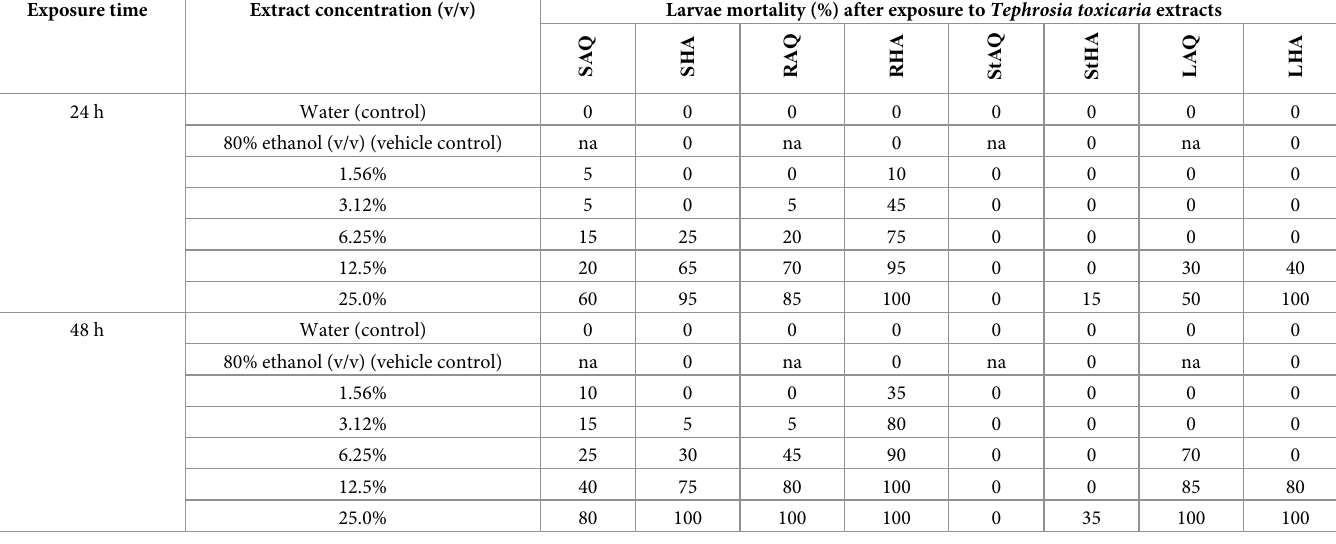
na: Not applied to aqueous extracts.